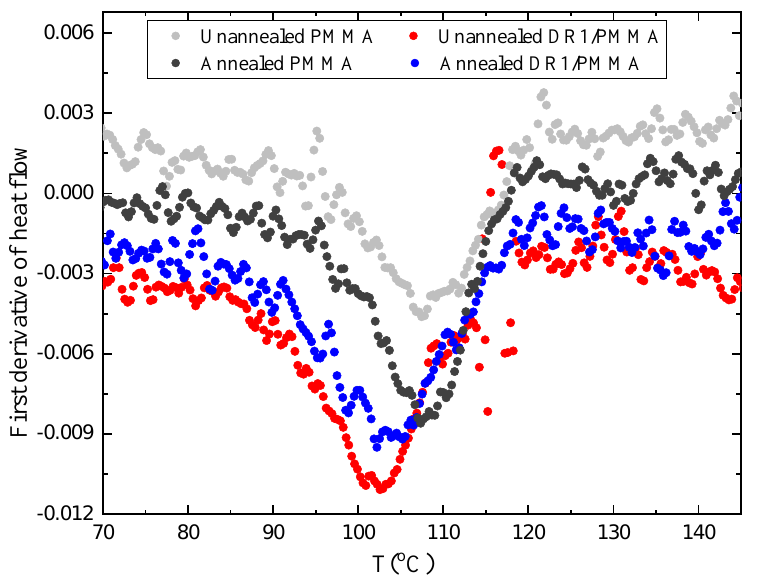
Figure 5. First derivative of heat flow from differential scanning calorimeter measurements of unannealed and annealed PMMA and DR1/PMMA fibers used to estimate the glass